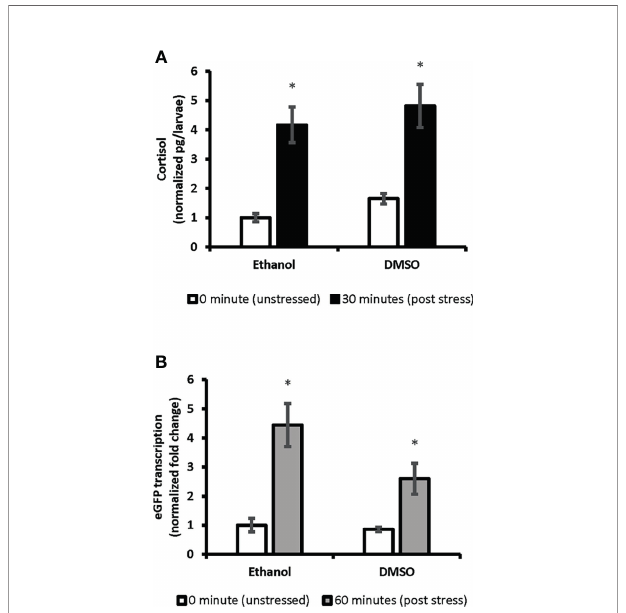
FIGURE 2 | The correlation between whole-body cortisol and total eGFP mRNA levels in SR4G transgenic zebra fi sh larvae. Panel (A) shows normalized whole-body cortisol levels and panel (B) shows normalized whole- body eGFP mRNA levels in the two control groups, Ethanol and DMSO, under the two unstressed and stressed conditions. Two-way ANOVA was performed to evaluate the effect of treatments and stress conditions on whole-body cortisol levels and whole-body eGFP mRNA levels. Means (± SEM) marked by an asterisk (*) are signi fi cantly different within each category (whole-body cortisol or whole-body eGFP mRNA study); p ≤ 0.0001; N=6. Ethanol: overnight exposure to 0.005% ethanol; DMSO: overnight exposure to 0.001% DMSO. The time points,30 min or 60 min, show the time-lapsed following the handling stress before euthanizing the subjects for sample collection. Each sample contained a pool of 22-28 of 7dpf SR4G transgenic zebra fi sh larvae. The correlation coef fi cient between whole-body cortisol and whole-body eGFP mRNA determined by the Pearson test and a positive correlation with r=0.947